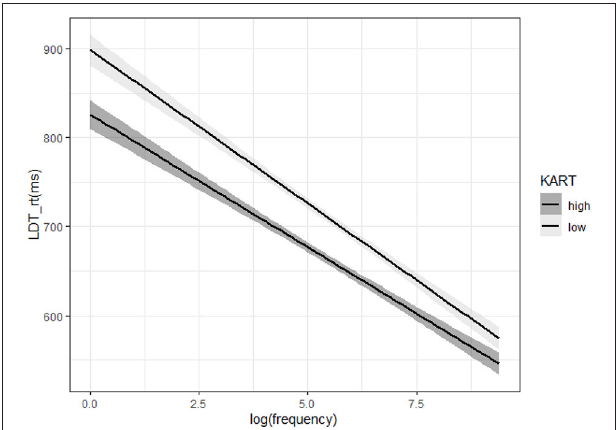
FIGURE 2 | Effects of word frequency and KART scores on reaction time (ms) in the lexical decision task. Note that the KART score variable was entered into the model as a continuous variable in the analysis. This variable is shown as a median split in the figure for the purposes of